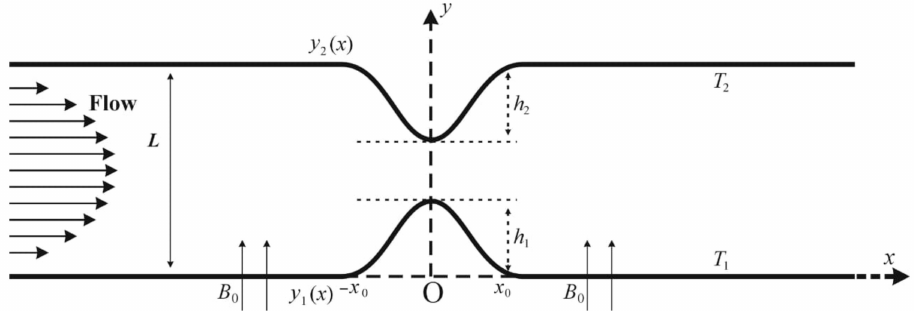
Figure 1. The channel geometry having a symmetric constriction on each of the